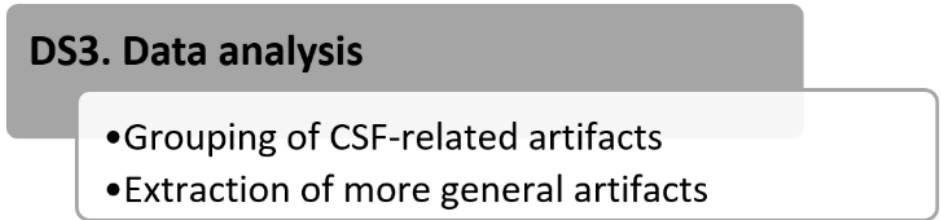
Figure 4. Design of CSFs: Stage 3.